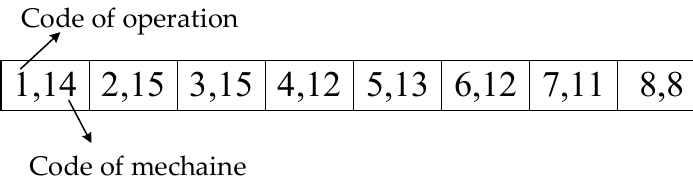
Figure 3. An examples of integrated coding methods for process planning.